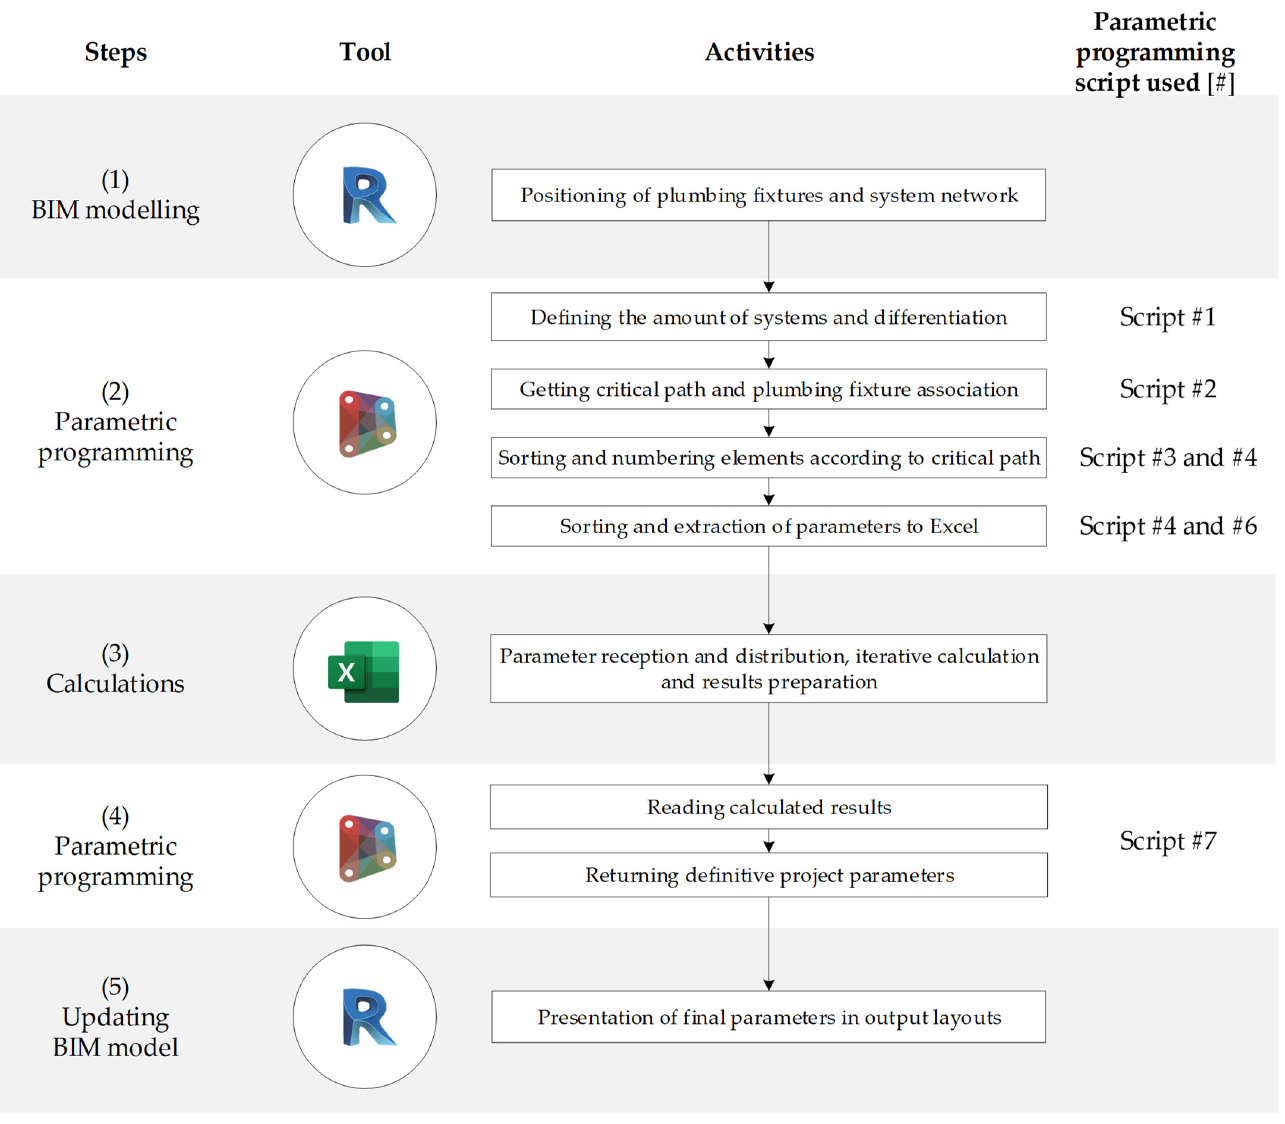
Figure 4. Activity sequence for automatic calculation of sanitary plumbing systems organised into five steps: (1) BIM modelling, (2) parametric programming, (3) calculations, (4) parametric programming and (5) updating BIM model. All the scripts are presented as Appendix A.